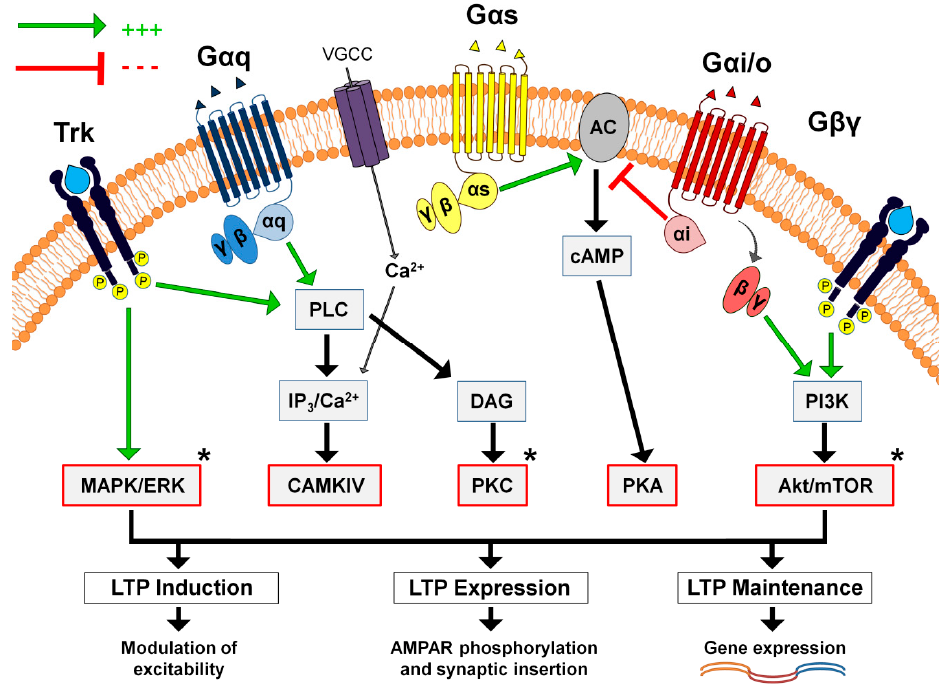
Figure 1. Schematic representation of the main metabotropic signalling pathways by which neuromodulators control long-term potentiation (LTP). Neuromodulators activate various protein kinases that can: Firstly, modulate neuronal excitability through controlling ion-channel conductance (e.g., NMDAR and VGCC) leading to the facilitation or direct induction of LTP. Secondly, protein kinases (e.g., PKA, MAPK and PKC) can initiate the expression, trafficking, phosphorylation and/or synaptic insertion of AMPA receptors leading to LTP expression. Lastly, protein kinases trigger the gene expression of proteins necessary for LTP maintenance. * It is also implicated in long-term depression (LTD), mostly through AMPA receptor internalisation.